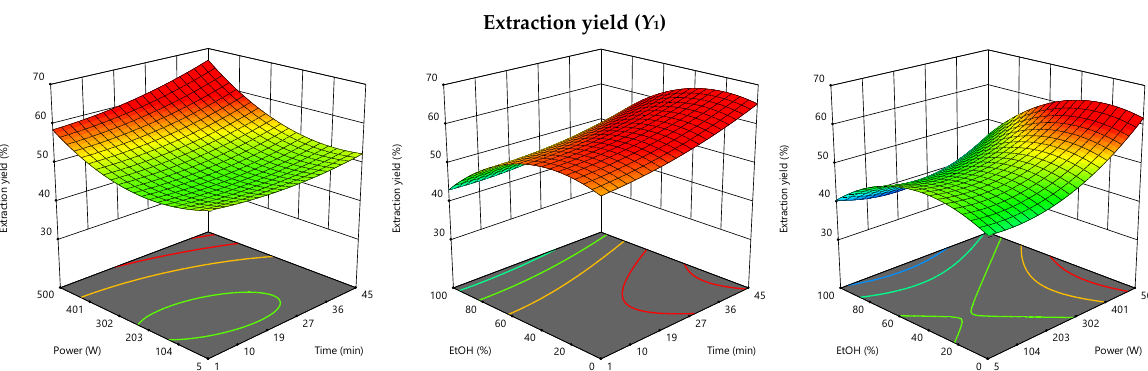
Figure 2. Response surface graphs for the combined effects of the independent variables on the total content of flavonoids ( Y 6 ) and extraction yield ( Y 1 ) obtained from kiwi peel. In each graph, the excluded variable was fixed at its optimal value.